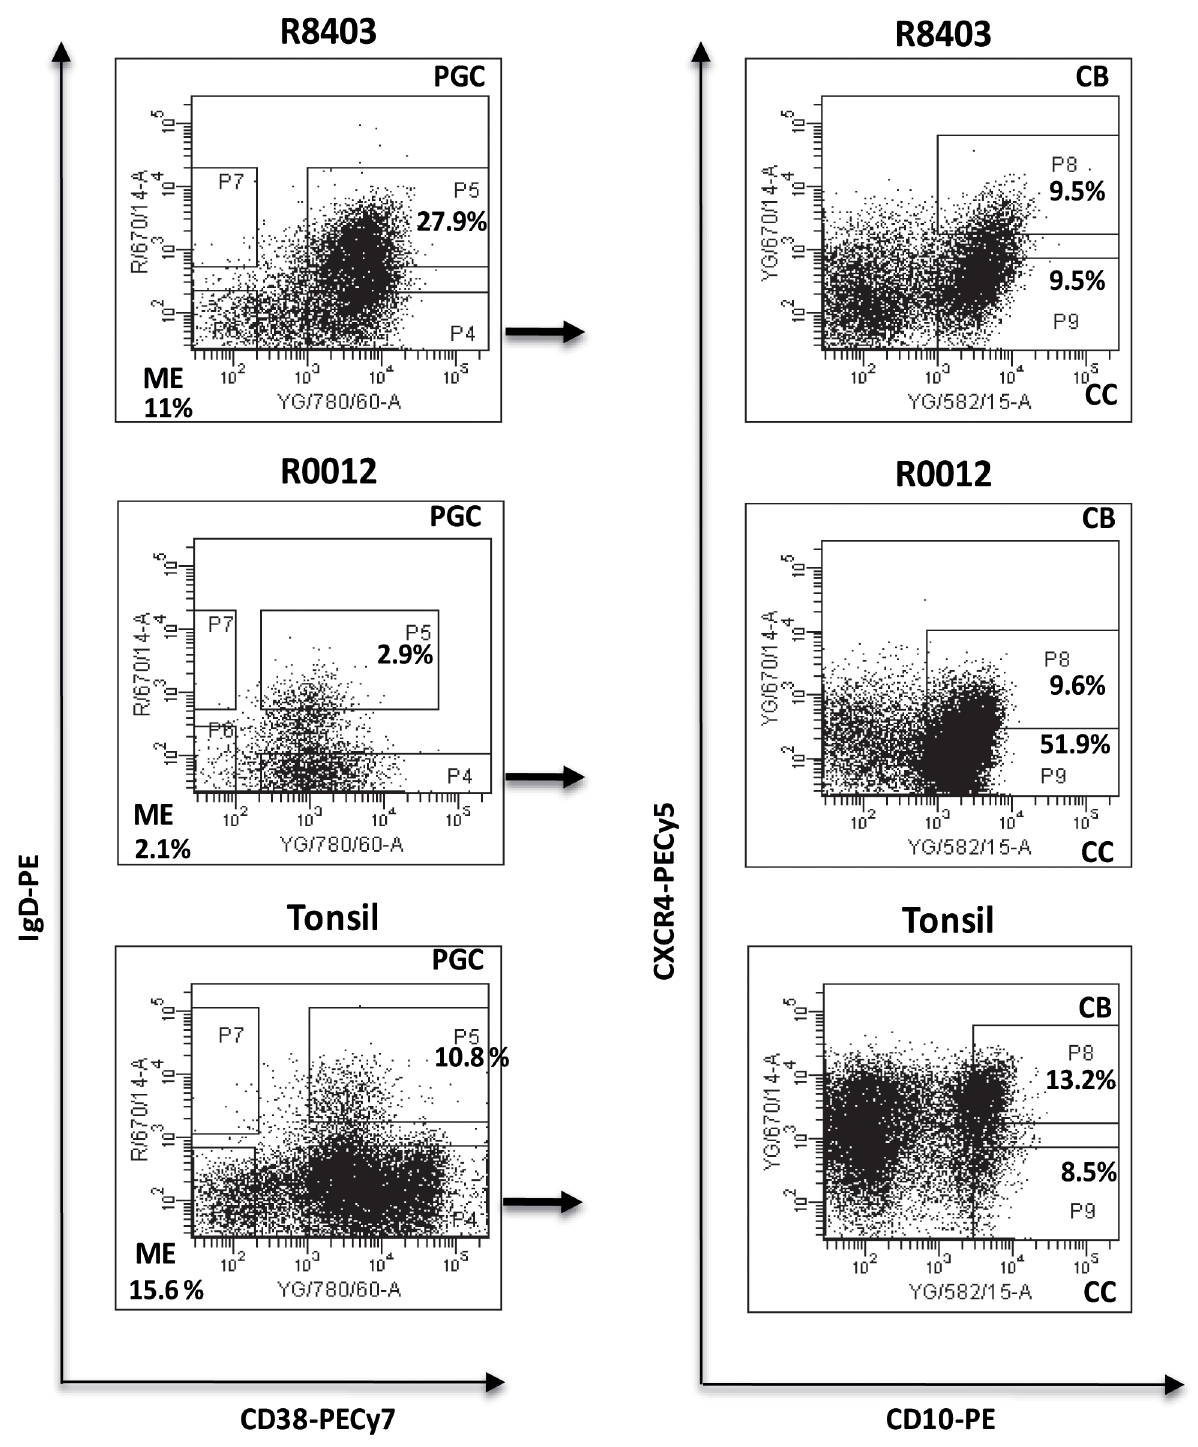
Fig 2. Flow-sorting of the 4 different B cell sub-populations. Lymph nodes cell suspensions from sequential biopsies obtained from patients with FL/t-FL were stained and sorted in 4 different populations according to the expression of IgD, CD38, CD10 and CXCR4. ME: IgD-CD38-; PGC: IgD+CD38+, CB: IgD-CD38+CD10+CXCR4+; CC: IgD-CD38+CD10+CXCR4-. Flow-cytometric identification of the 4 sub-populations in the sample R8403, patient 3 (top), sample R0012, patient 1 (middle) and tonsils (bottom). In the 2 patients samples the numbers indicate the percentage of the gated and sorted subsets whilst in the tonsil example the numbers are representative of 8 independent experiments on as many different